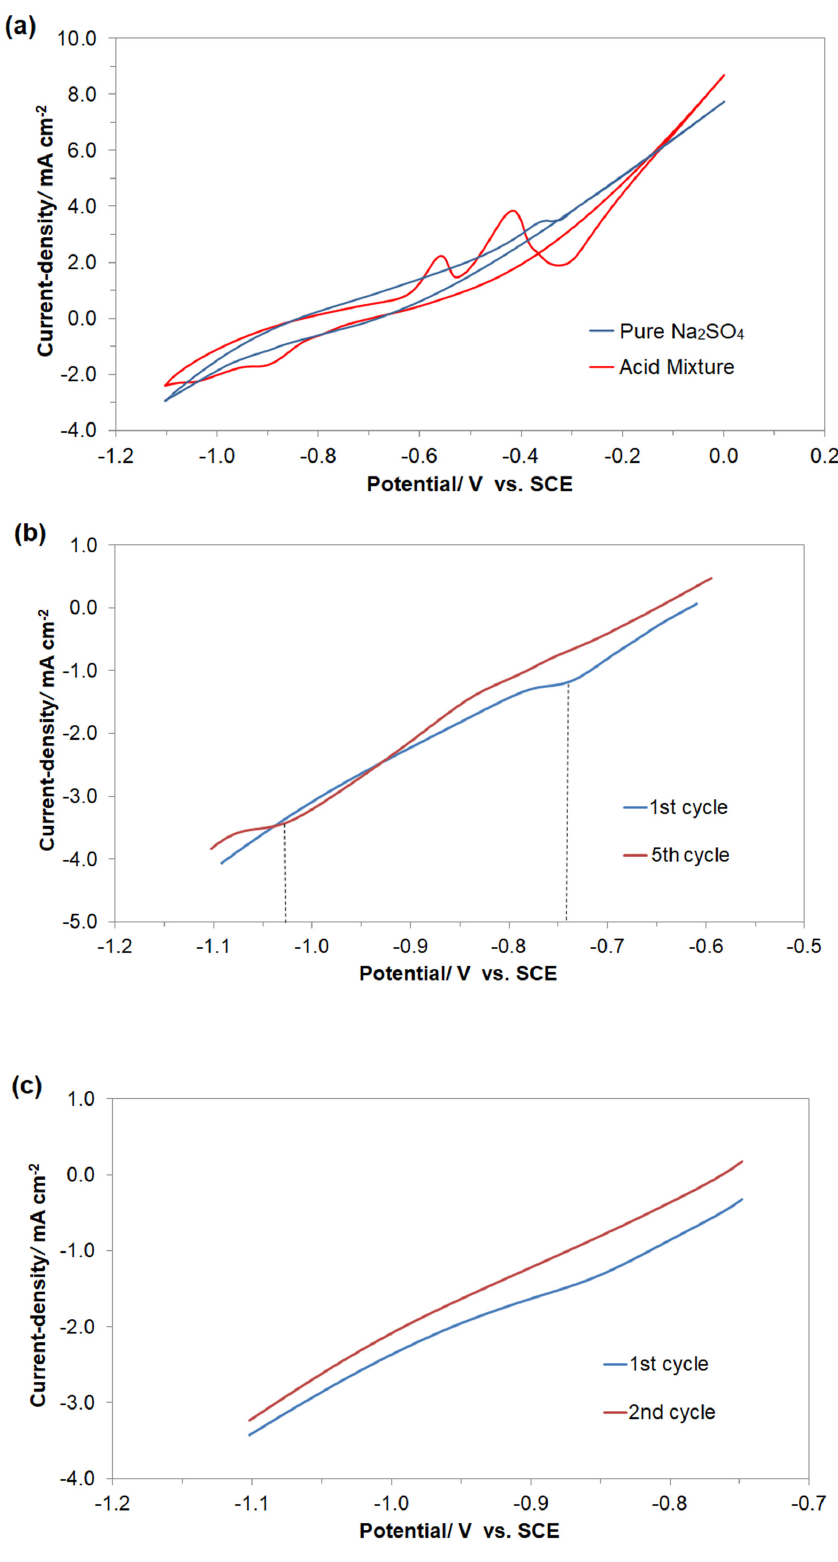
Figure 3. ( a ) Cyclic voltammetry behaviour of the Cu/Fe galvanic cell in the absence and presence of AM dye (at 50 mg dm − 3 ), recorded in 0.054 M Na 2 SO 4 supporting electrolyte, at a sweep-rate of 50 mV s − 1 and 293 K (third cycle); ( b ) shift of the peak potential value for the recorded cathodic reduction process upon continuous cycling; ( c ) disappearance of cathodic reduction peak upon cycling over the potential range narrowed to − 1.1–( − 0.75) V. For the cyclic voltammogram recorded in the absence of the AM dye, two irreversible anodic peaks could clearly be observed, namely a low potential and very broad feature, centered at about − 0.85 V, and another one positioned at ca. − 0.35 V vs. SCE. Thus, the former peak is related to the process of Fe(II) formation, whereas the latter one could be allotted to its further oxidation to form Fe 3 O 4 or Fe(OH) 3 surface layers [34–36]. Then, having introduced 50 mg dm − 3 of AM dye into the electrolyte, two well-pro- nounced oxidation features (centered at ca. − 0.56 and − 0.42 V) appeared upon cycling to- wards more positive potentials. It is strongly believed that these anodic patterns corre- spond to consecutive surface oxidation (commencing with nitrogen-to-nitrogen bond cleavage) of the examined dye’s constituents [37–40]. Afterwards, as the cycling becomes